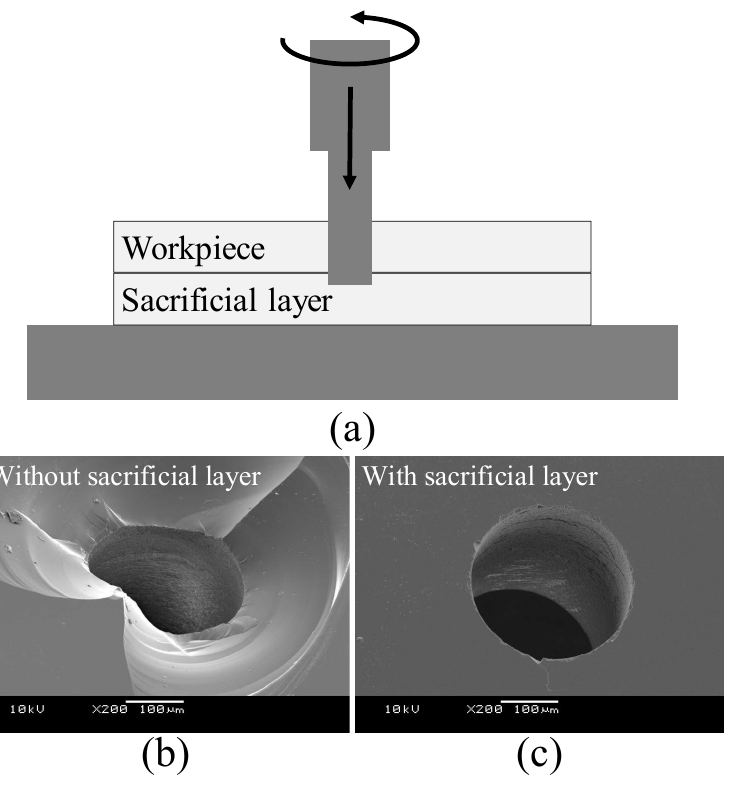
Figure 10. ( a ) Microdrilling using a sacrificial layer, and ( b , c ) SEM images of the exit side of the through hole (drilling conditions: axial feedrate 5 µ m/s; rotational speed of 50,000